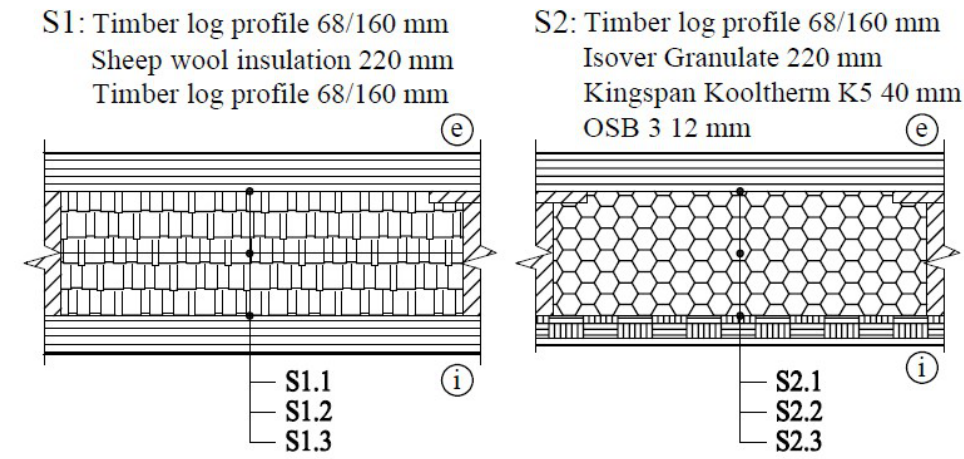
Figure 1. Left South wall 1 (S1), right South wall 2 (S2) – layers, probes placement.